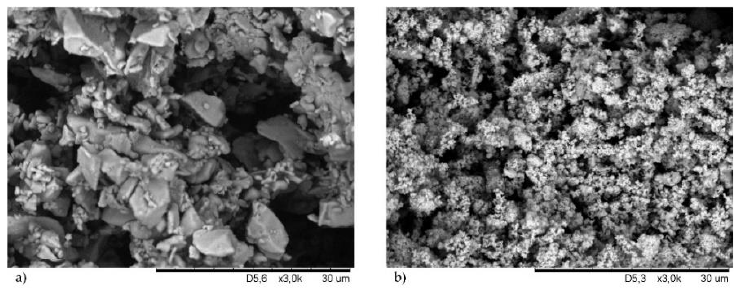
Figure 1. Morphology of cross-linking agents: Cu 2 O ( a ); CuO ( b ).